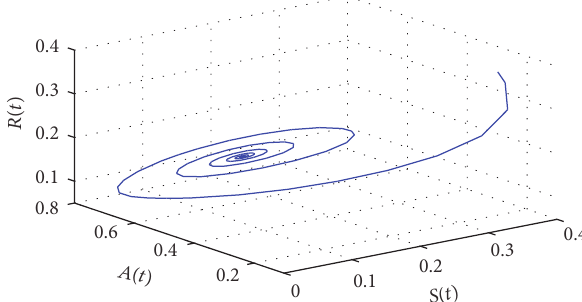
Figure 5: The phase plot of states 𝑆 ∗ , 𝐴 ∗ , and 𝑅 ∗ with 𝜏 2 = 58.48 < 95.9606 = 𝜏